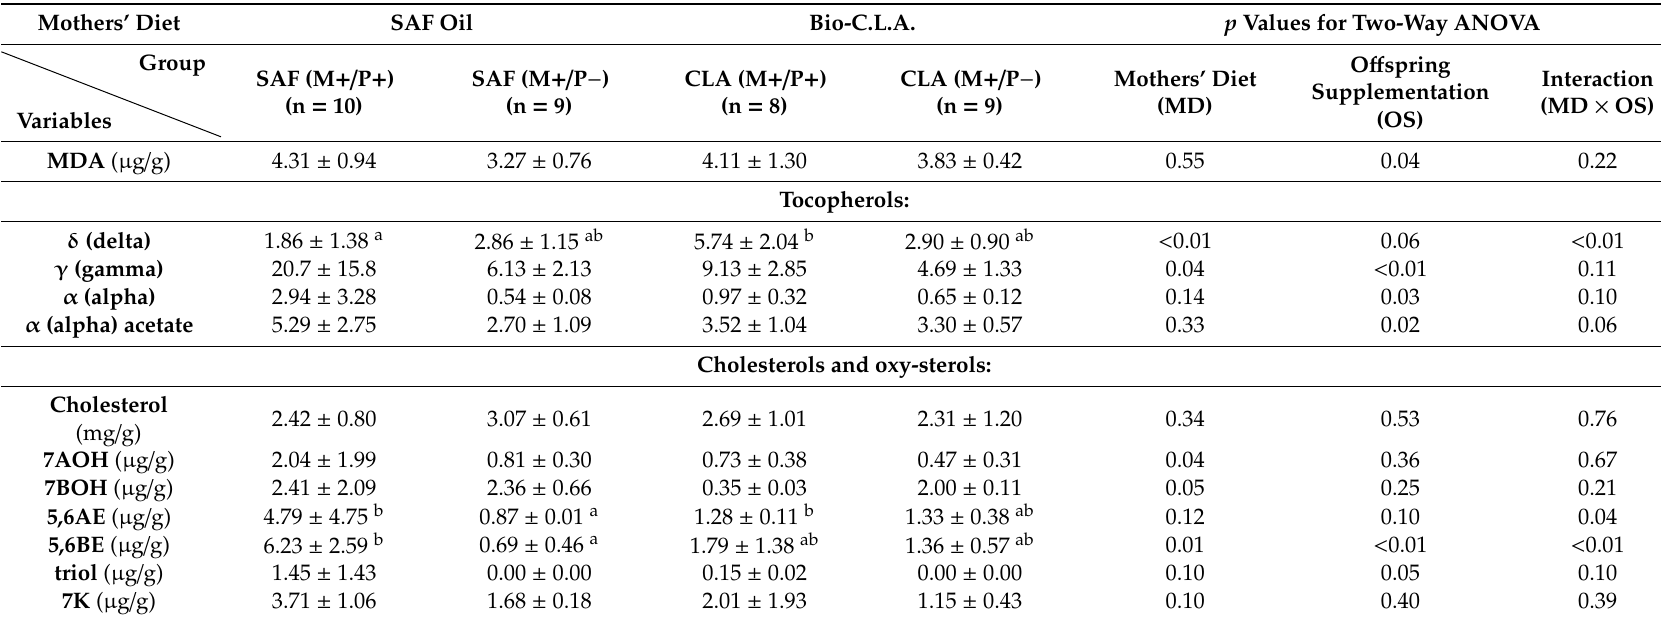
Table 4. The contents of malondialdehyde (MDA), tocopherols, cholesterol and their oxidized derivatives in the hearts of o ff spring of mothers supplemented with sa ffl ower oil (SAF oil) or Bio-C.L.A., in whom supplementation with the same preparation was continued (SAF(M +/ P + ); CLA(M +/ P + )) or not (SAF(M +/ P − ); CLA(M +/ P −